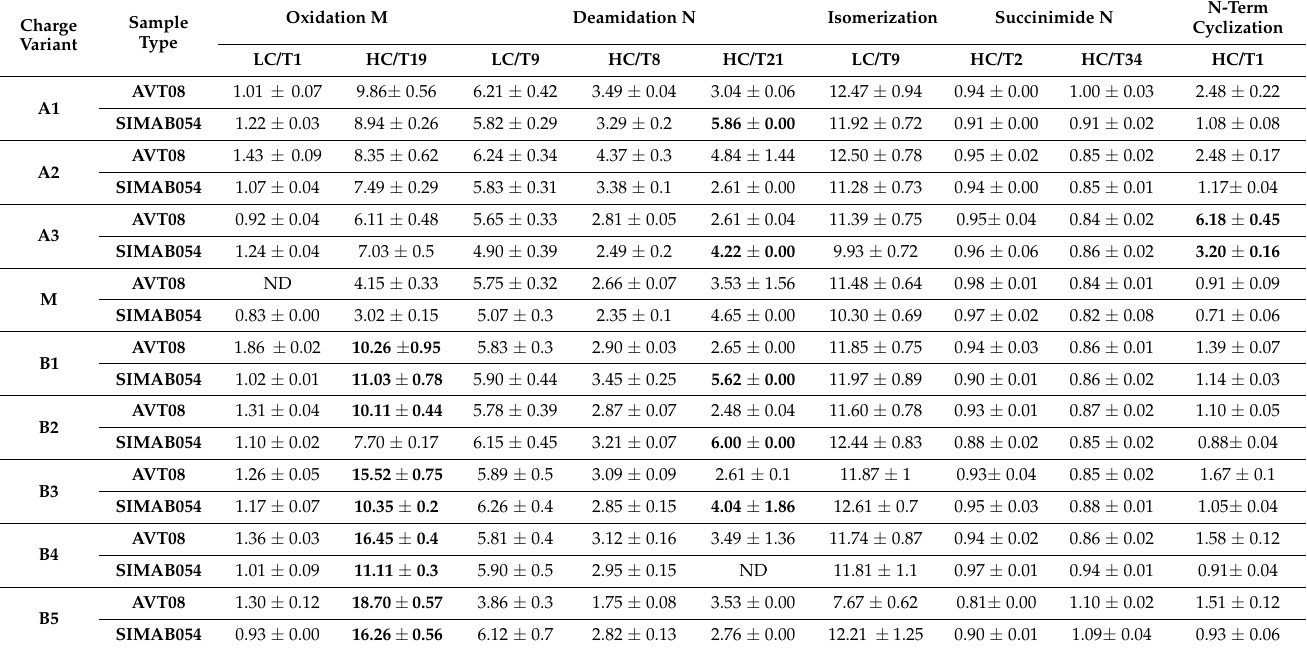
Table 1. The post-translational modification alterations of selected peptides in all charge variant frac- tions. The results were obtained by peptide mapping analysis of AVT and SIMAB054. The percentage values were calculated by averaging three separate injections, indicating standard deviations. A, M, and B represent acidic, main, and basic fractions. HC, heavy chain; LC, light chain; TX, tryptic peptide number in the indicated